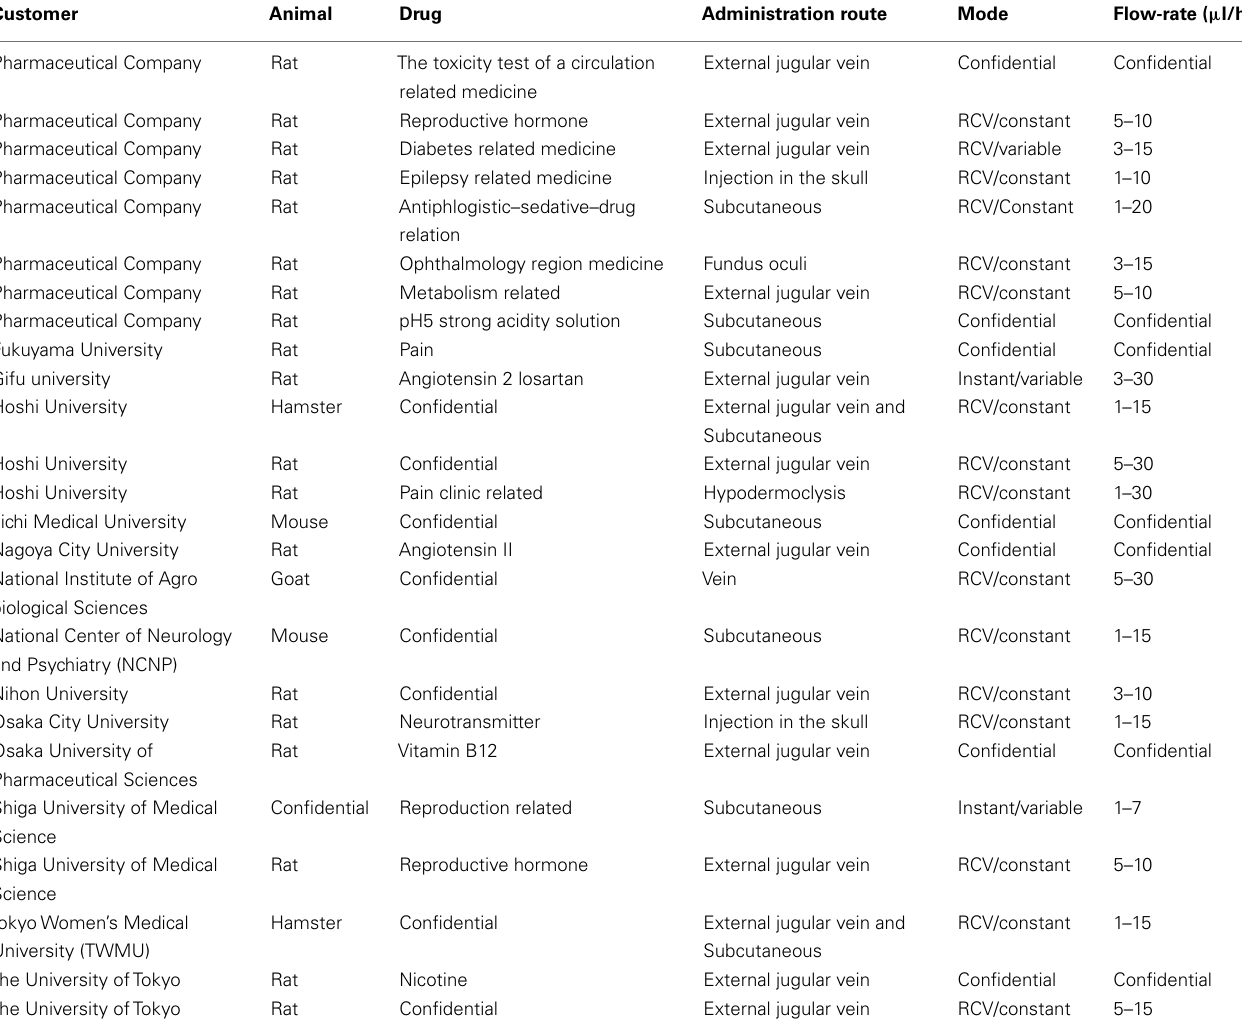
Table 1 | Selected examples of iPRECIO ® applications in Japan with details of species, agent/drug, administration site, and infusion